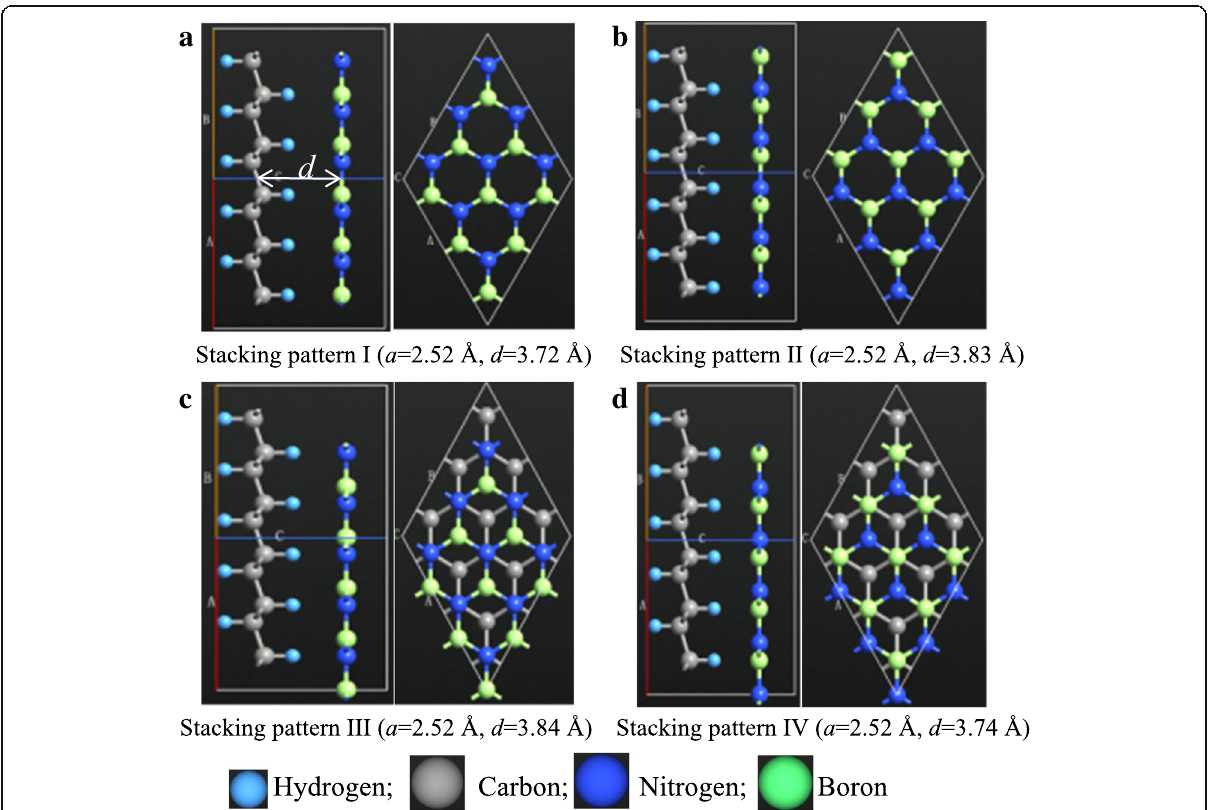
Fig. 1 a – d Possible stacking patterns of 100%-HG/h-BN